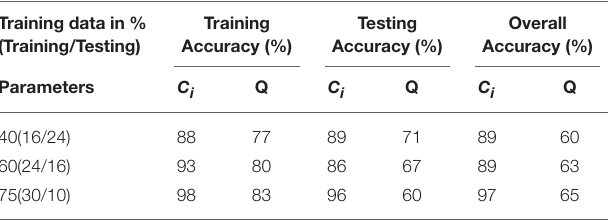
TABLE 2 | SVM results for the three different training (%) data sets for parameters derived from cortical thickness. Training data in % (Training/Testing)